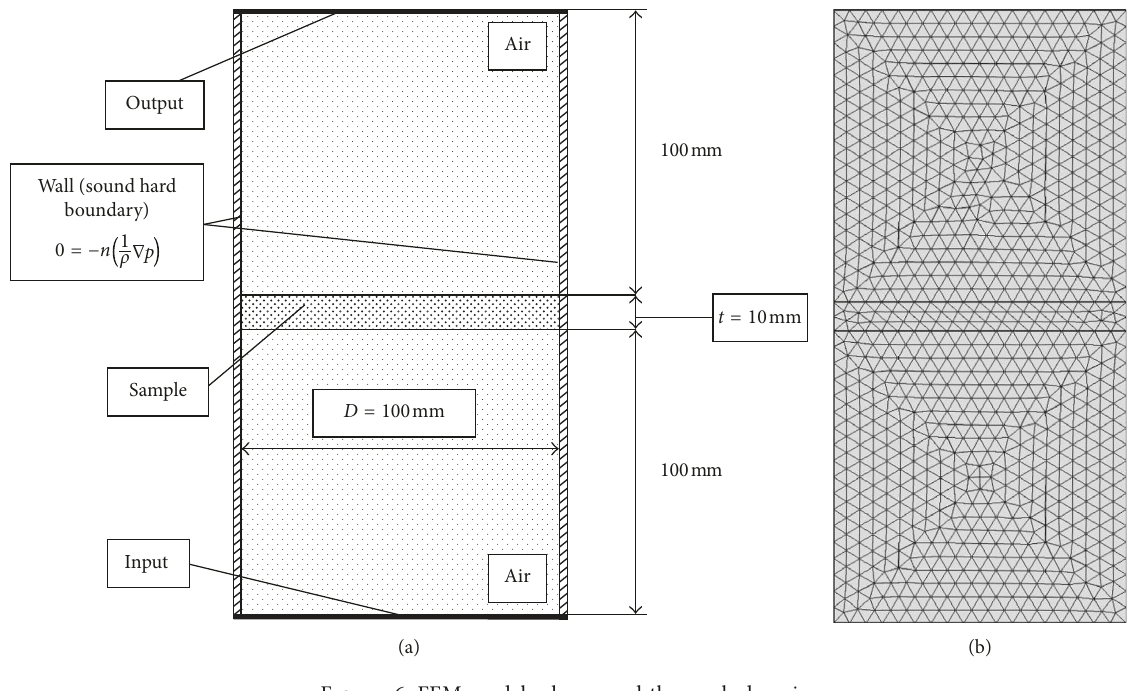
Figure 6: FEM model scheme and the mesh domain.